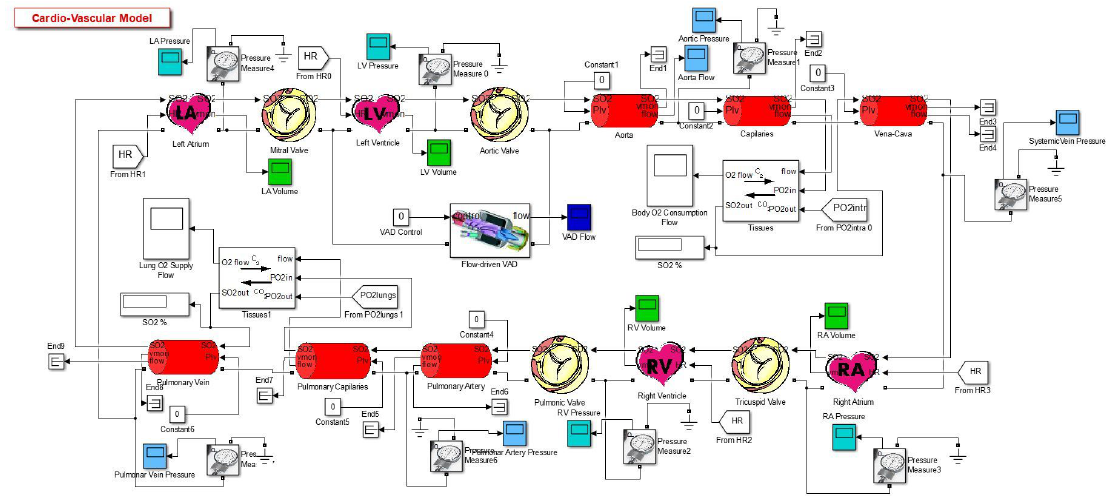
Figure 1. Complete model